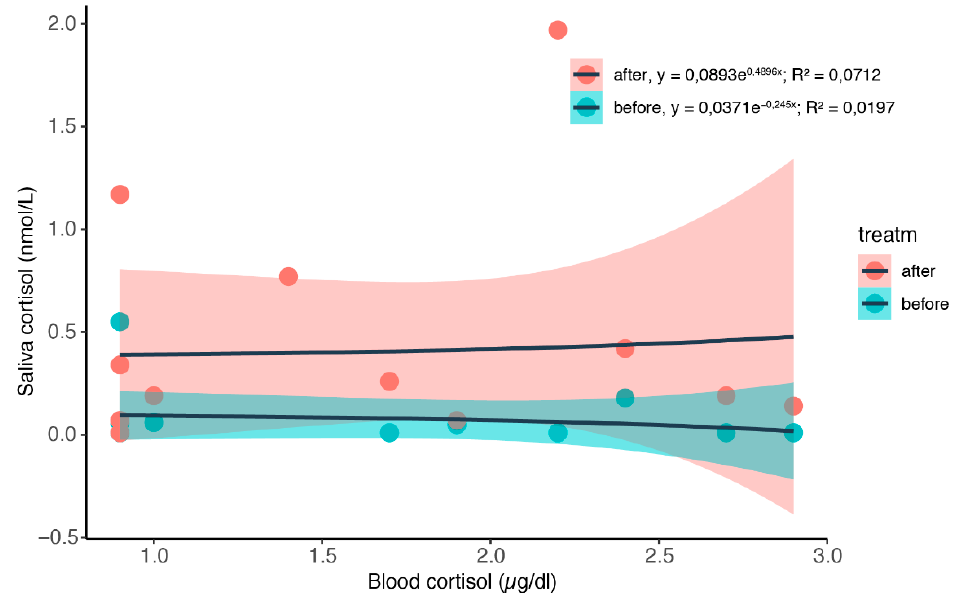
Figure A3. Correlation between blood cortisol values and saliva values during restriction. A loga ‐ rithmic curve was fitted. Saliva samples were taken before (green dots) and after (red dots) the blood samples; see Figure 3 for an exemplarily sampling scheme. Three dolphins were sampled (Jenny =